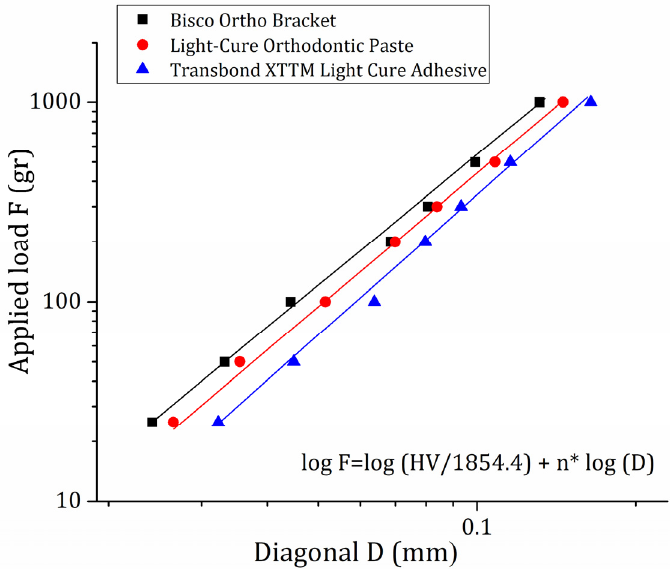
Figure 5. Logarithmic plots of applied load (F) vs. diagonal length (D) for: Bisco Ortho Bracket (black squares), Light-Cure Orthodontic Paste (red circles) and Transbond XT TM Light Cure Adhesive (blue triangles). Straight lines are linear regressions of each dataset.